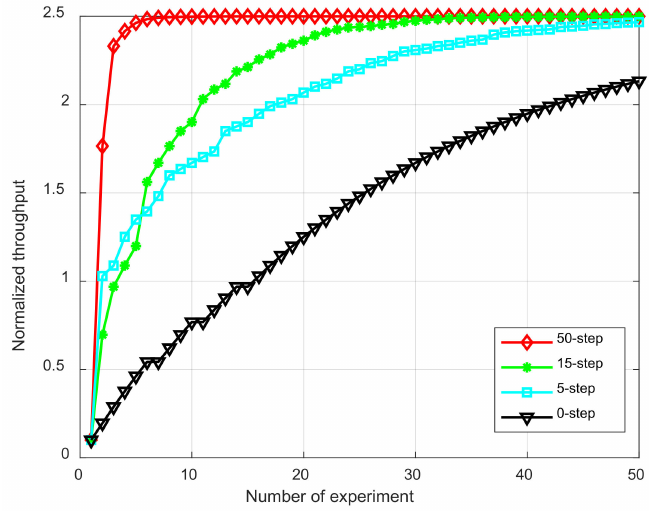
Figure 8. Rewards per act for different